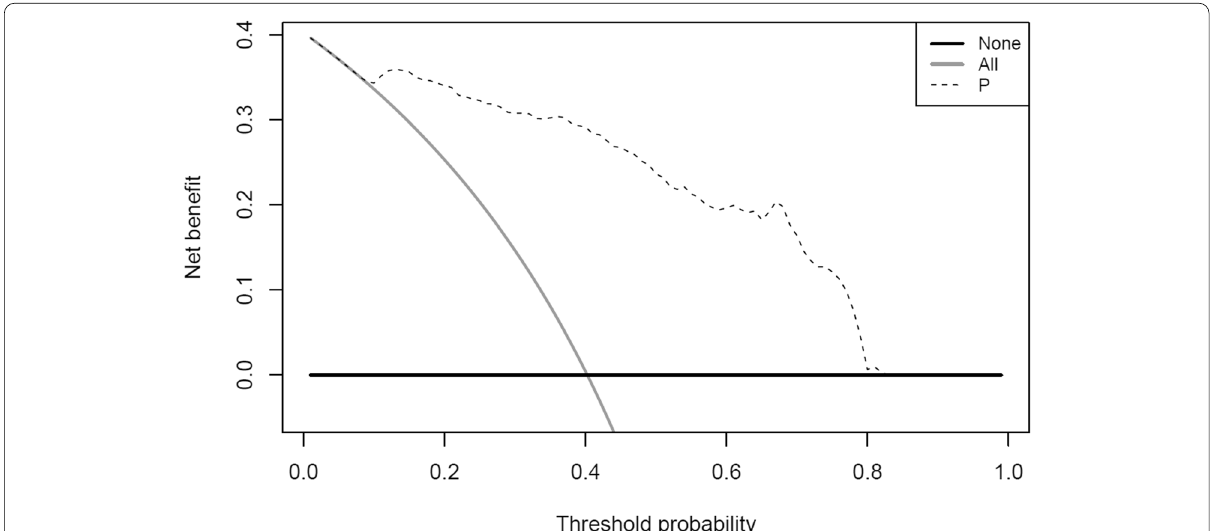
Fig. 4 Decision curve analysis. Decision curve analysis plotting net benefit at all threshold probabilities for the Delta Study algorithm. Solid lines show the net benefit assuming that all patients are bipolar (grey), and assuming that all patients have MDD (black). The dotted line represents the net benefit of the Delta Study algorithm. MDD: Major depressive